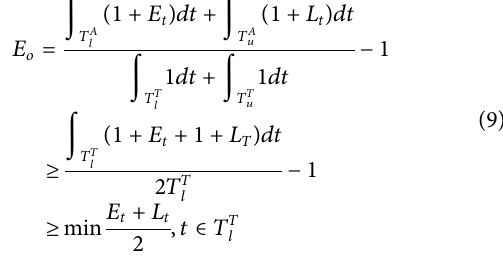
Frontiers in Robotics and AI |